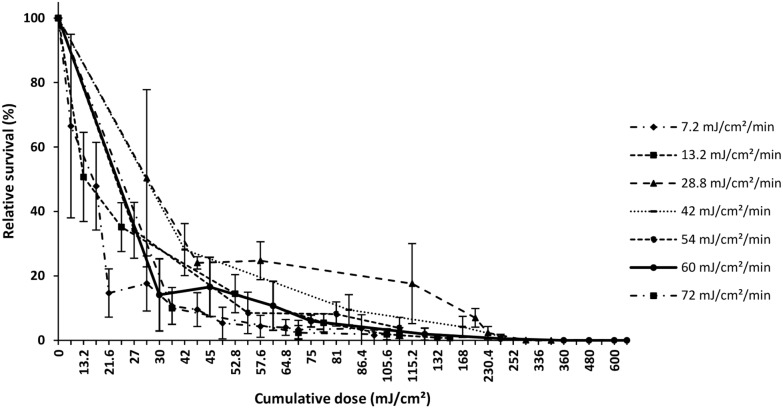
Percent survival relative to controls of treated groups exposed to different cumulative UV-doses in the range 7.2–720 mJ.cm−2.Error bars represent standard deviations of means (STD).